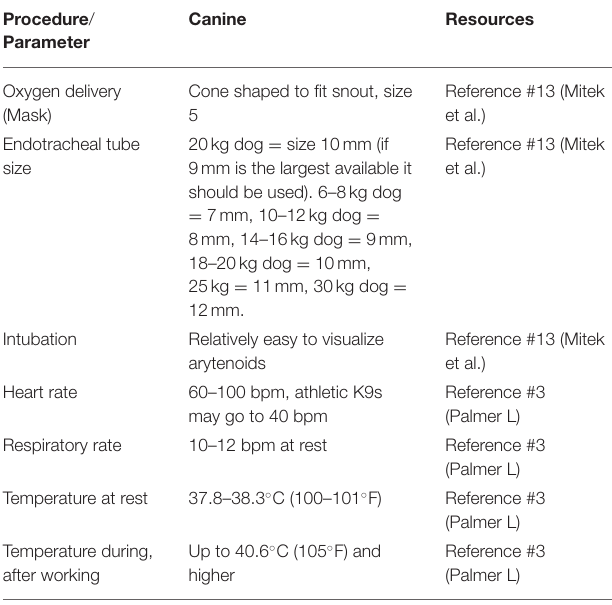
TABLE 1 | K9 specific equipment and physical